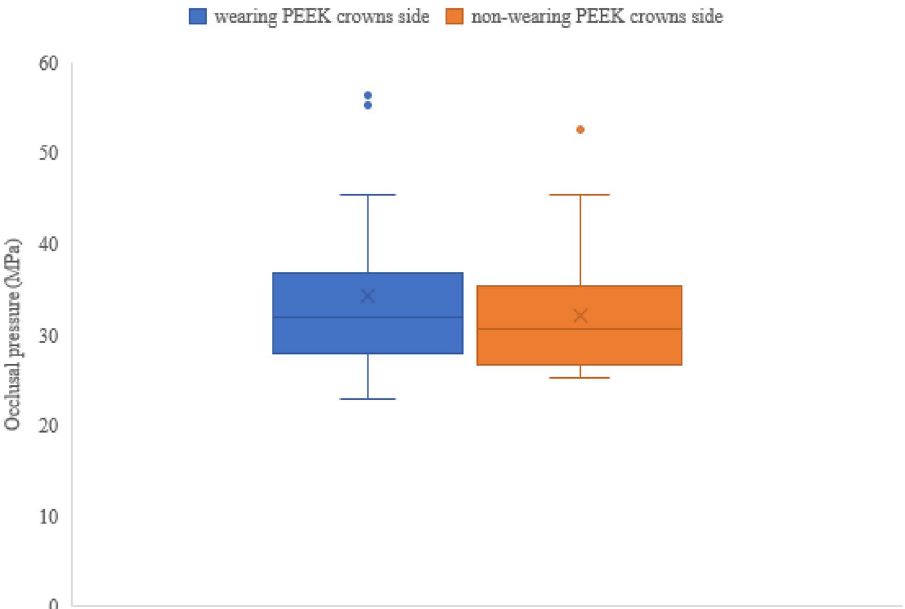
Figure 8. Boxplot of Occlusal pressure in wearing PEEK crowns side and non-wearing PEEK crowns side. Box; inter quartile range (IQR), Lower whisker ; minimum, upper whisker ; maximum, Center line; median, cross mark; mean. The blue and orange dots represent outliers. *Mann–Whitney U test shows no significant difference between PEEK and non-PEEK wearing